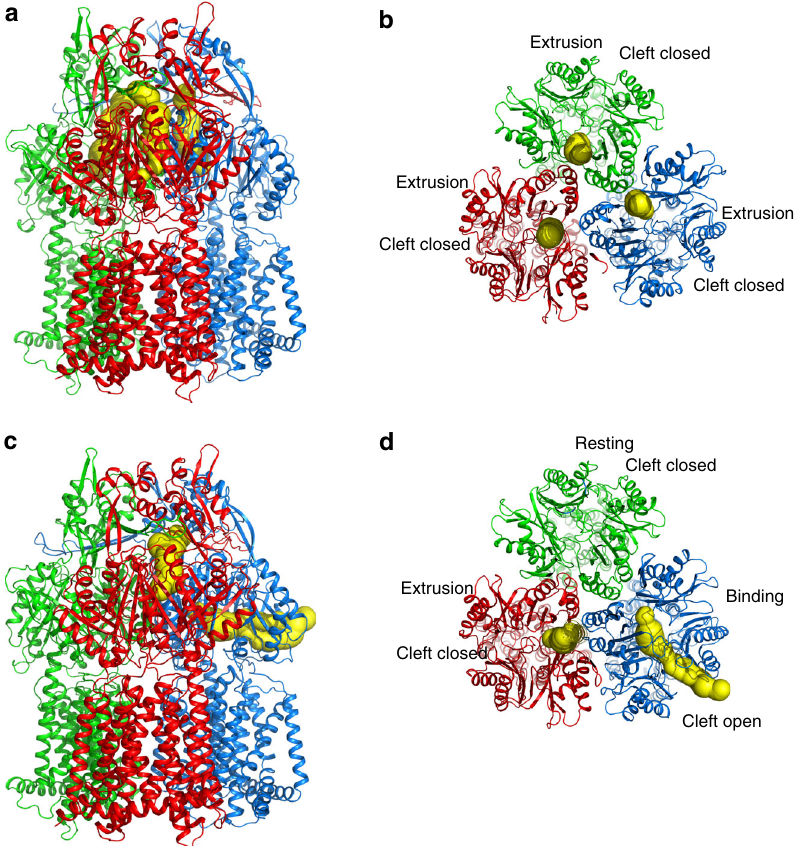
Fig. 2 Channels in the CmeB pump. a Side view and b top view of the channels formed by the periplasmic domain of the form I structure of the CmeB trimer. Each protomer creates an extrusion channel for drug export. c Side view and d top view of the channels formed by the periplasmic domain of the form II structure of the CmeB trimer. The “ extrusion ” protomer generates an extrusion channel that is similar to those observed in the form I structure. The “ binding ” protomer constitutes a channel, which leads through the opening of the periplasmic cleft and is exposed to solvent. The “ resting ” protomer does not form any channel. These channels were calculated using the program CAVER